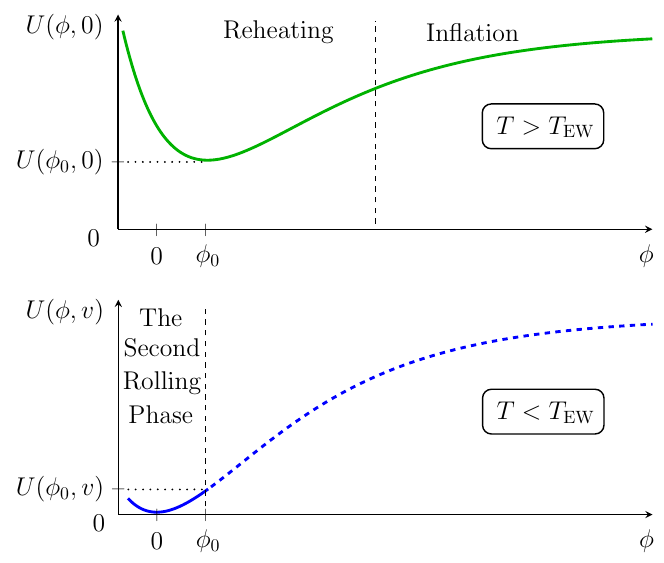
Figure 2 . The potential (2.3) before electroweak symmetry breaking when h = 0 (top) and after when h = v (bottom). The solid blue curve is the region where the second rolling triggered by electroweak symmetry breaking takes